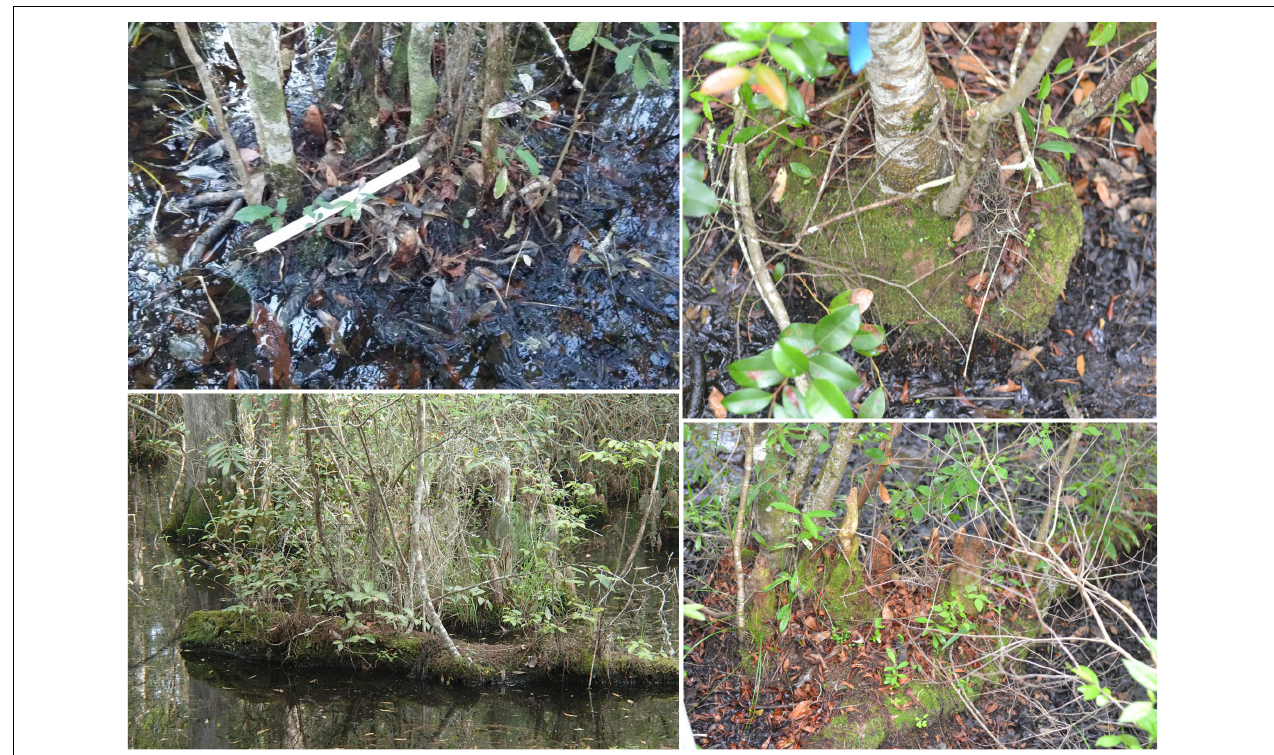
FIGURE 2 | Wax myrtle stems on hummocks of different heights and sizes at the Strawberry Swamp field site; in the top left panel, a ∼ 0.3 m ruler is